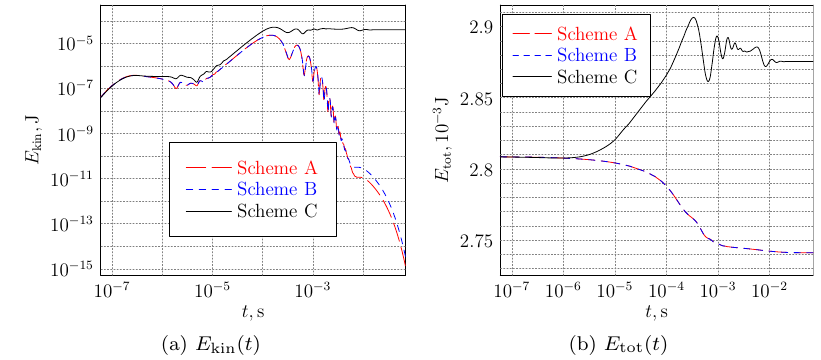
Figure 9. Problem 3.2: plots of E kin ( t ) and E tot ( t ) for schemes A , B and C obtained for the body force potential Φ of form (4.3).